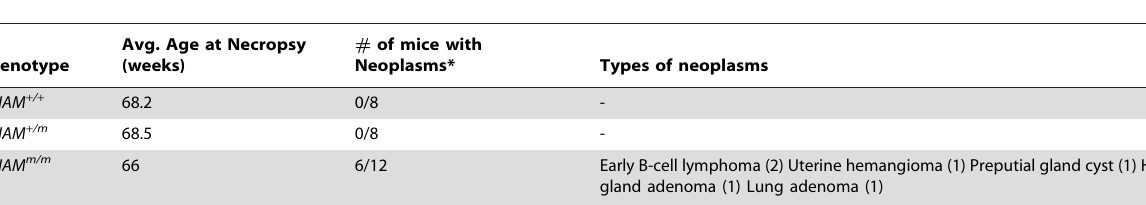
Table 2. Neoplastic lesions in NIAM -deficient